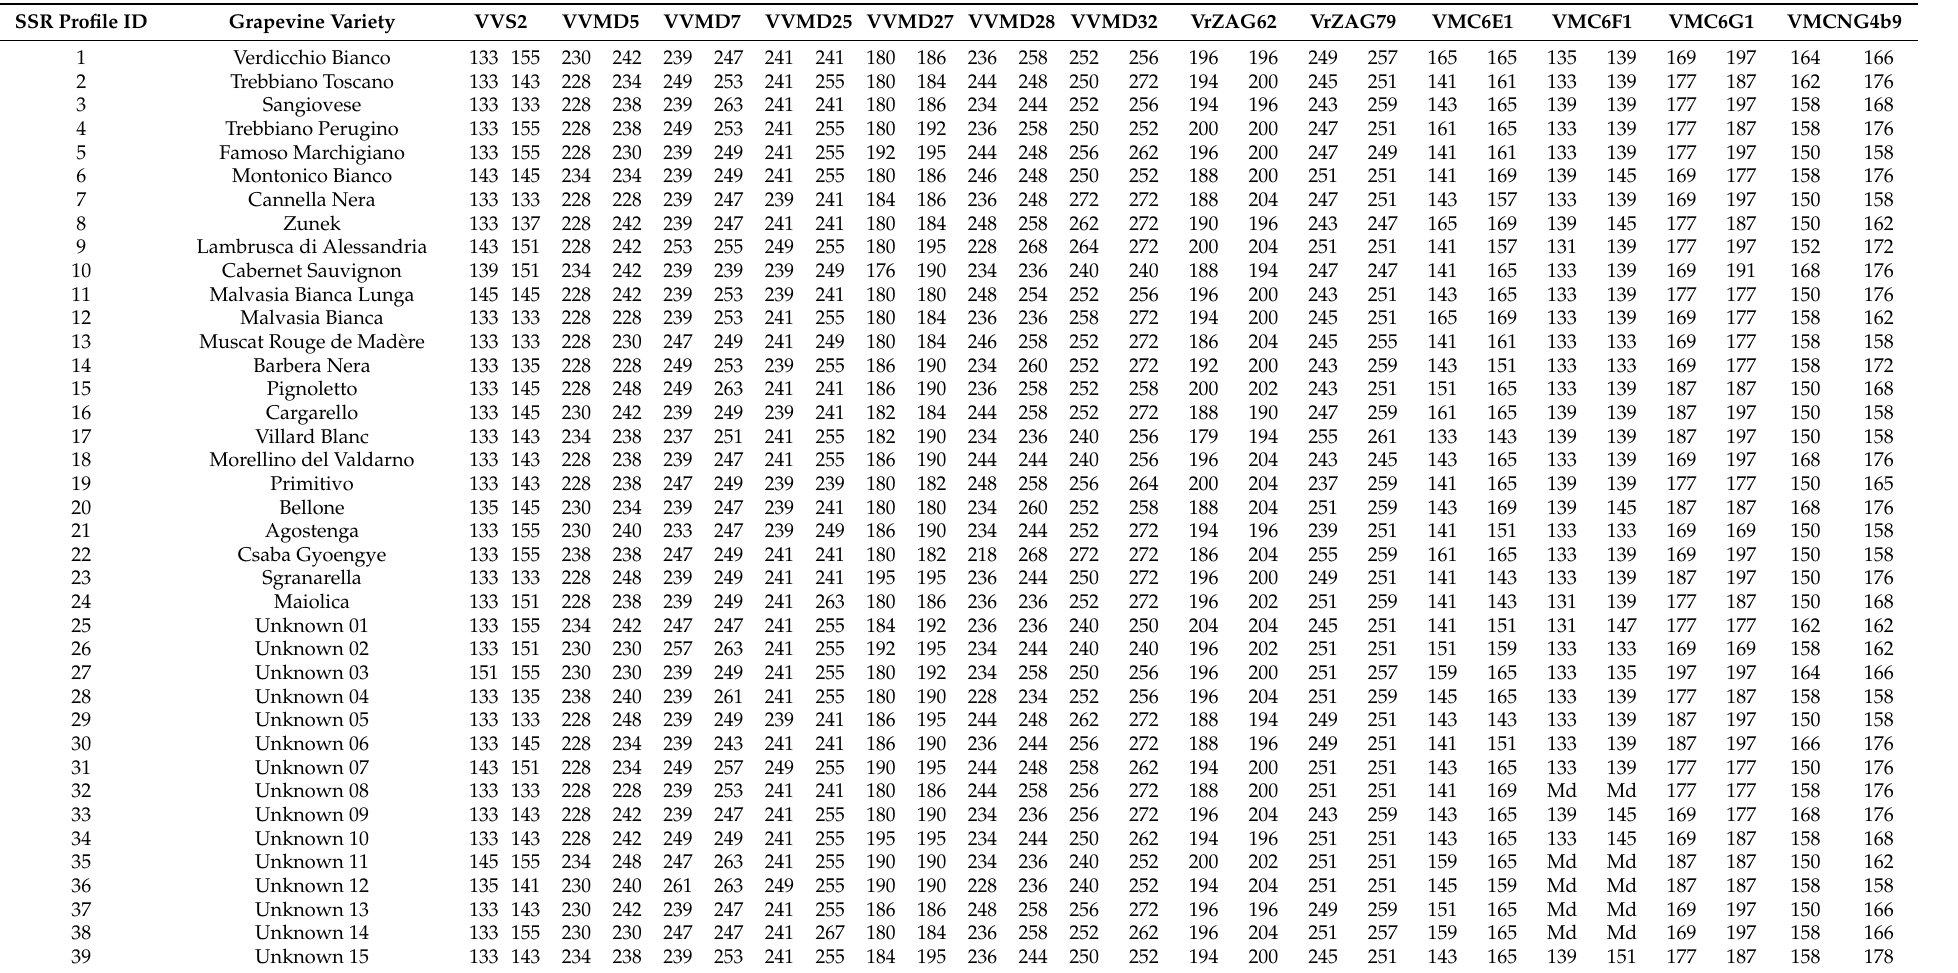
Table 2. List of 39 unique genetic profiles obtained at 13 SSR